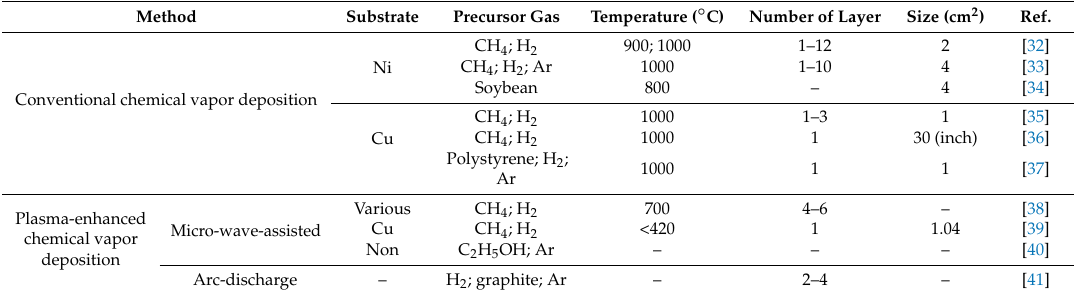
Table 3. Typical graphene properties for various kinds of chemical vapor deposition.